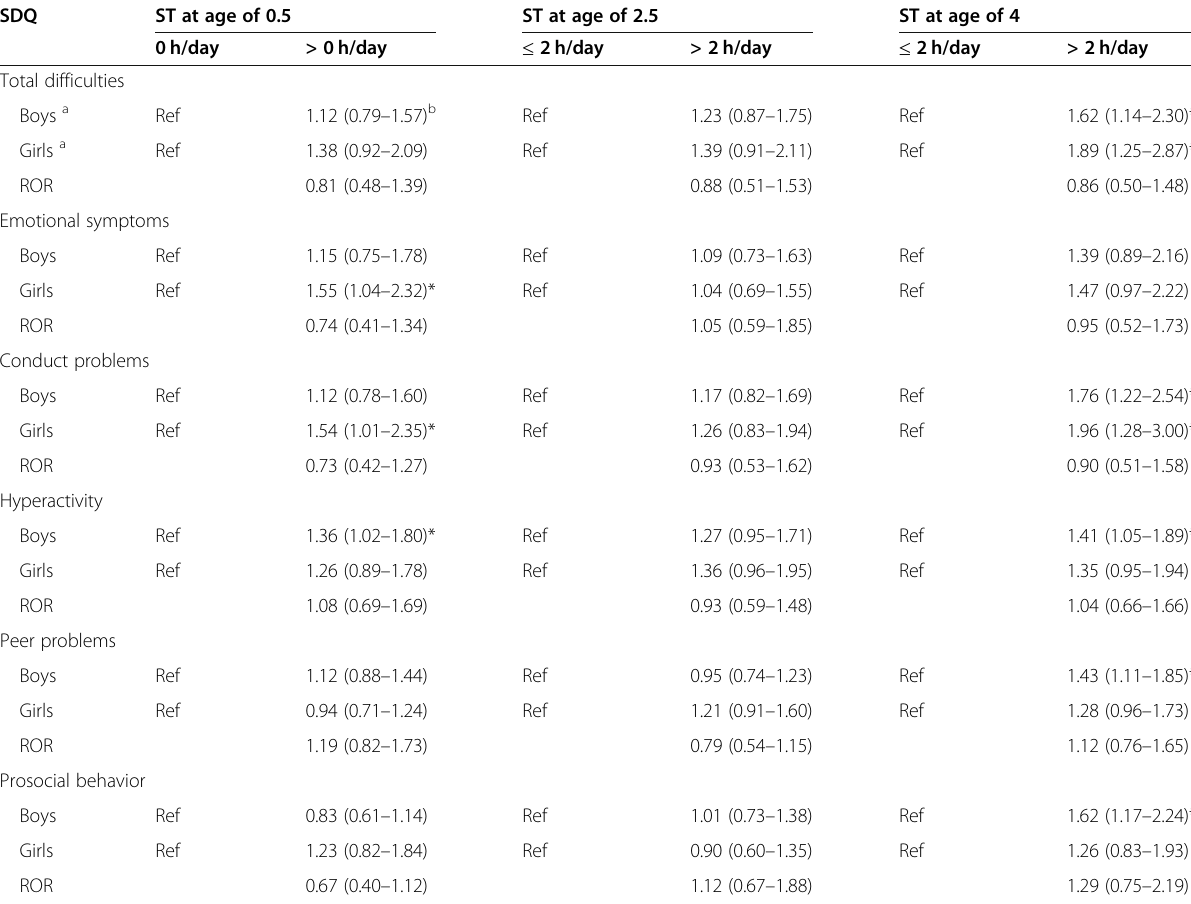
SDQ Strength and Difficulties Questionnaire, ROR ratio of two odds ratio in boys versus girls a Adjustment for age, number of siblings, delivery model, birth weight, maximum educational level of parents, family income, passive smoking, outdoor activities b OR odd ratio, CI confidence interval * P < 0.05; ** P < 0.01